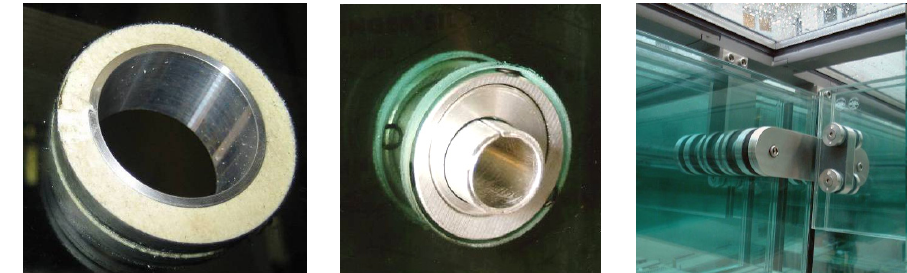
Figure 1a, b and c: Mortar-Interlayer to create ductility behaviour and example of a joint (CCI Munich)